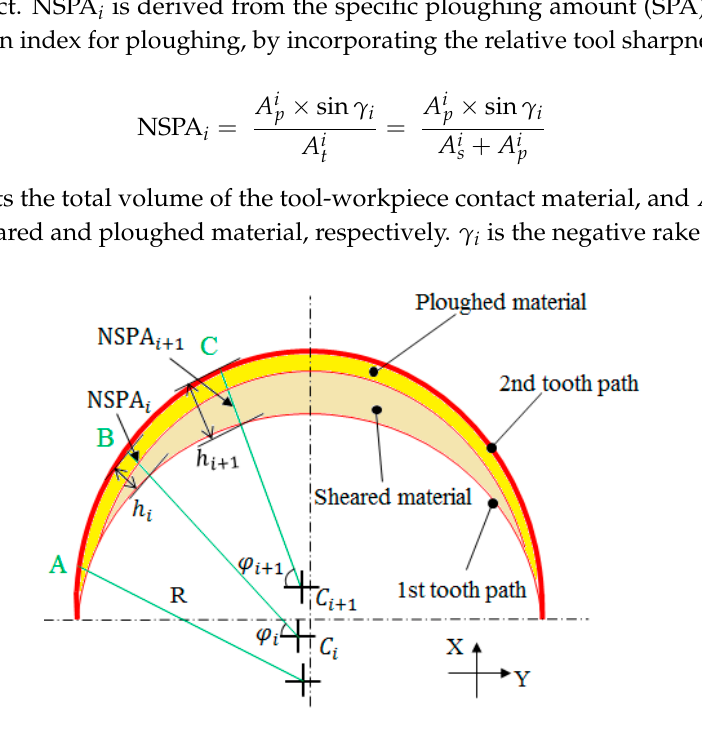
Figure 2. Model for the calculation of NSPA i